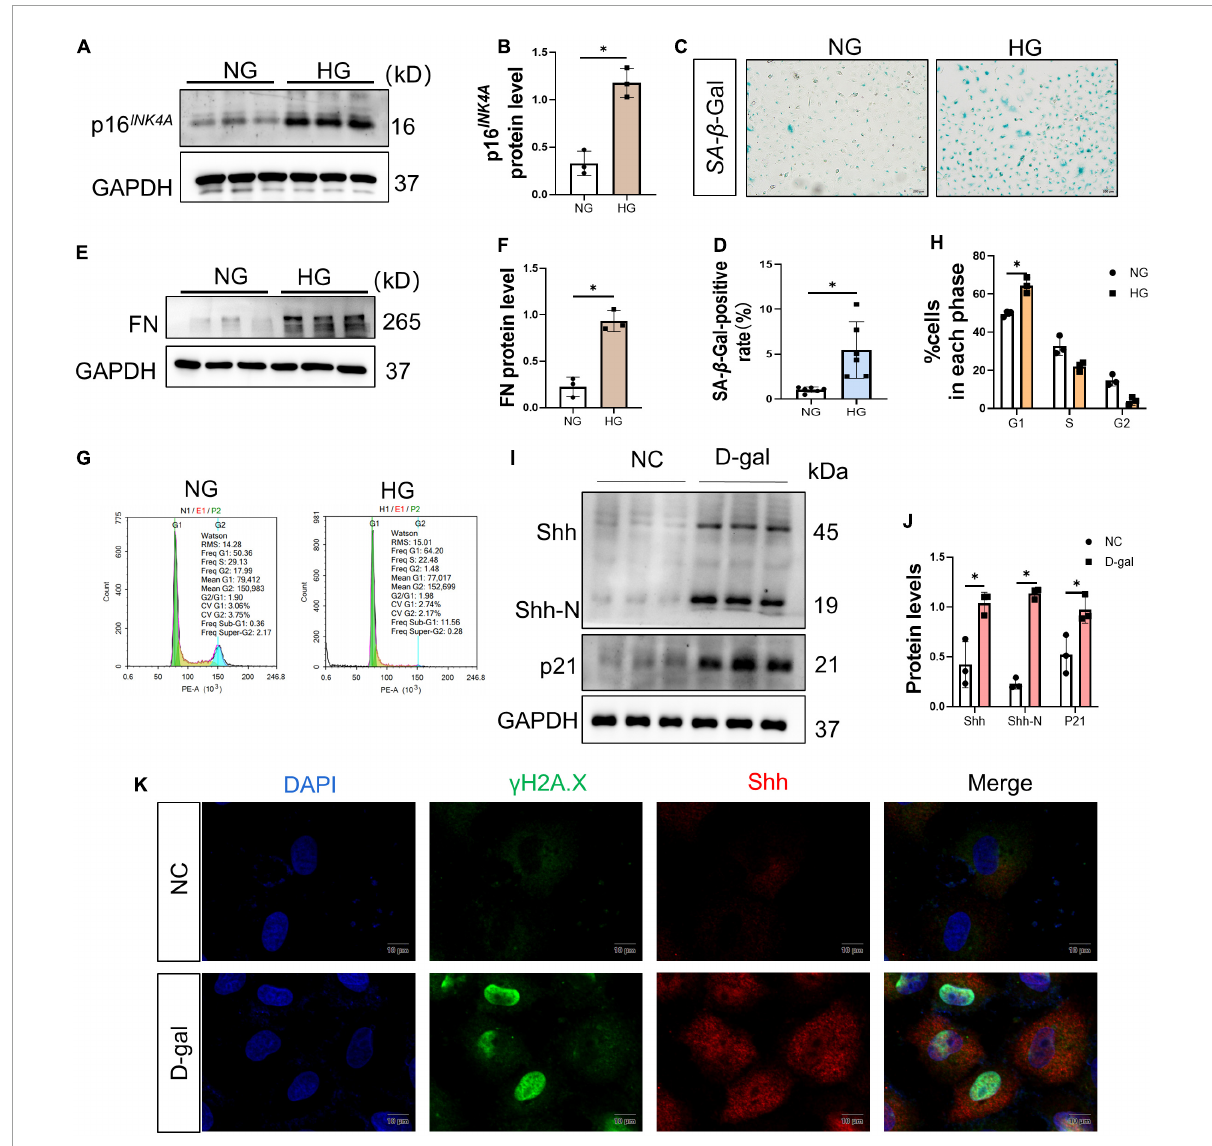
FIGURE5 High glucose (HG) mediates renal tubular epithelial cell senescence and fibrosis. (A,B) Western blot analyses showed p16 INK 4 A protein in each cell group. Representative Western blot (A) and quantitative data (B) are presented. (C,D) Detection of SA- β -galactosidase (SA- β -Gal) activity in renal tubular epithelial cells. (C) Representative images of renal tubular epithelial cells are shown. The ratio of SA- β -Gal-positive cells is presented in the panel (D) . Scale bar = 200 µ m. (E,F) Western blot analyses showed the FN protein level in each cell group. Representative Western blot (E) and quantitative data (F) are presented. (G,H) Flow cytometry analysis of each group of cell cycle (G) and quantitative data (H) . HG prevents cell exit from G1 into S phase. Represents the high percentage of G1 phase in the HG group than in the NG group. (I,J) Western blot analyses showed Sonic hedgehog (Shh) and p21 protein in each cell group. Representative Western blot (I) and quantitative data (J) are presented. (K) 4 mg/ml D-gal intervention in NRK-52E cells. Representative micrographs showed immunofluorescence staining of γ H2A.X and Shh in different groups. DAPI staining (blue) represents cell nucleus, Bar = 10 µ m. All data are presented as mean ± standard deviation (SD) from three independent experiments. n = 3; ∗ P < 0.05 vs. NC